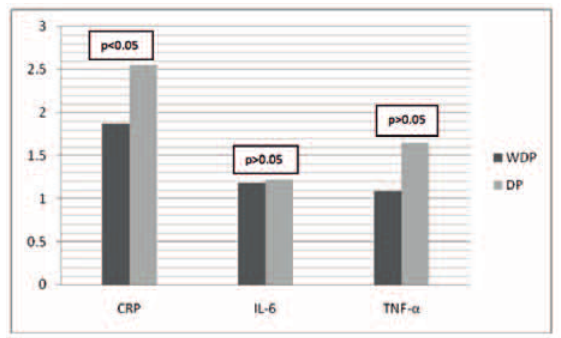
Figure 3. Infl ammatory cytokines and diabetic polyneuropathy. WDP – without diabetic polyneuropathy; DR – diabetic